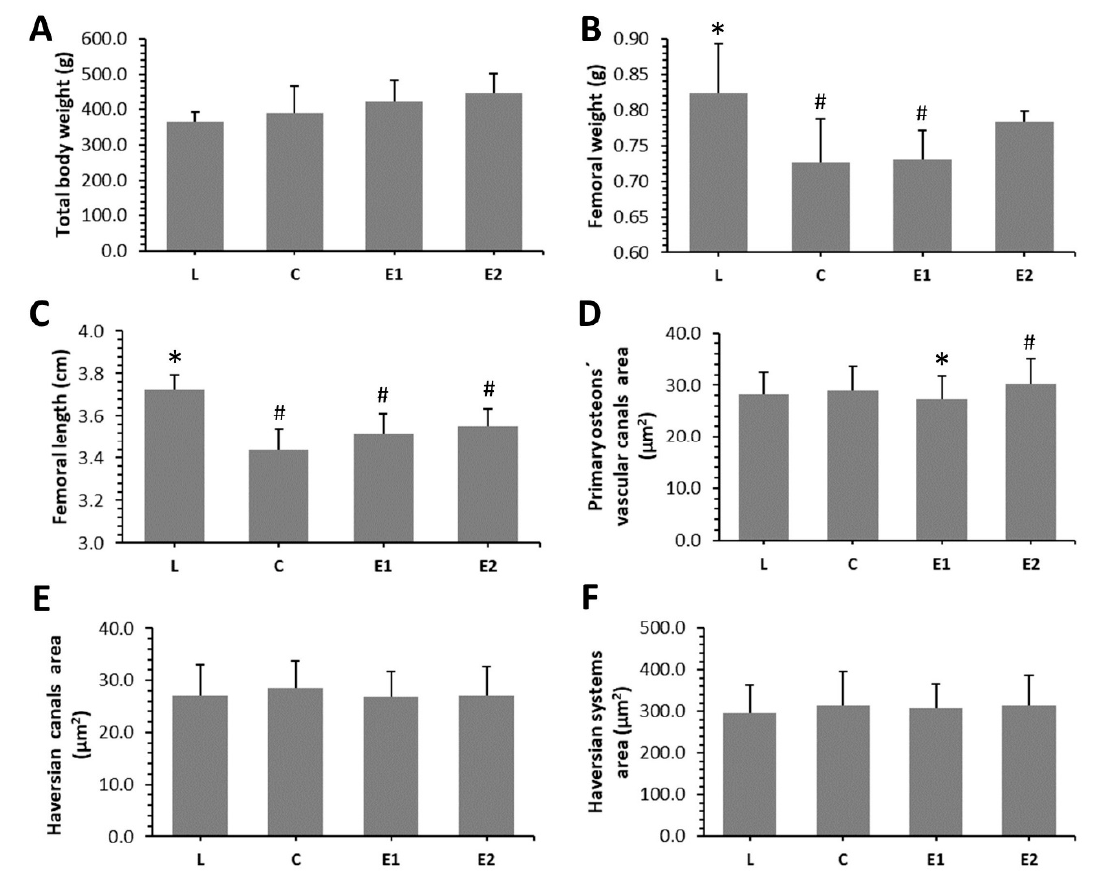
Figure 2. Macroscopical ( A – C ) and histomorphometrical ( D – F ) parameters examined in ZDF rats from L, C, E1 and E2 groups * Significant differences versus C group ( p < 0.05). # Significant differences versus L group ( p < 0.05).